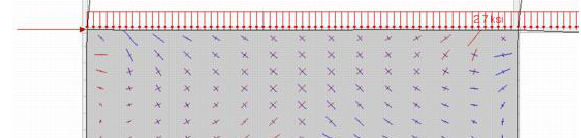
Figure 7: average stress state at different points In the figure above, the small crosses that are drawn at each point represent the average stress state within the corresponding brick group. The crosses are oriented according to the principal directions of the stress state, and each leg of the cross is drawn with a length proportional to the corresponding principal stress. Red indicates tension, and blue indicates compression.